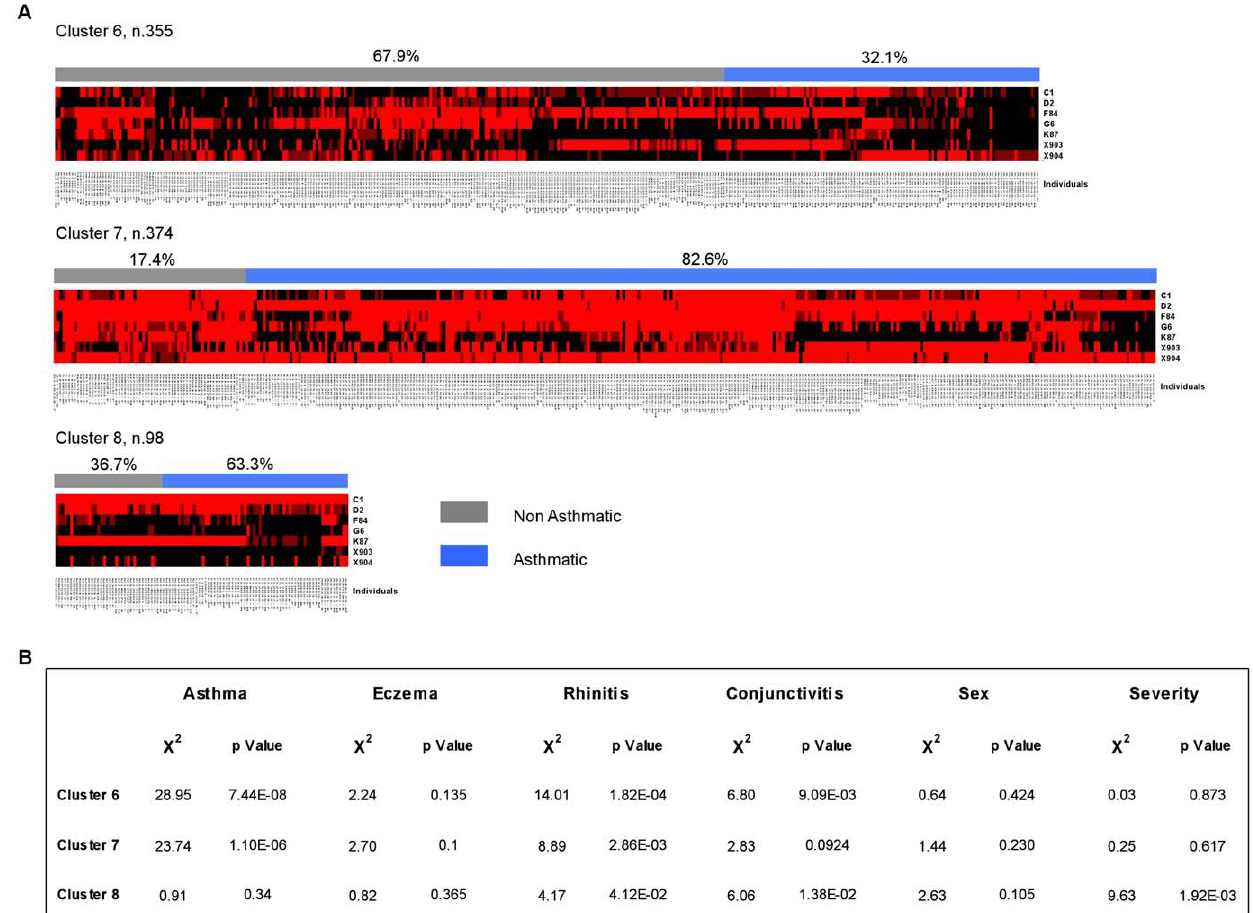
Figure 4. K-means clustering of serum reactivity profiles of 827 sera (columns) against the subset of asthma relevant allergens (rows). (A) The serum reactivity profile generated for each cluster (6–8) at k =3 are visualized. Each column represents an individual serum grouped as asthmatic (blue) and non-asthmatic (gray). Reactivity values to individual allergens are classified as either positive (scale of red - class score 1–5) and negative (black - class score 0). (B) The distribution of atopic conditions in each cluster was assessed using the Pearson’s X 2 test.